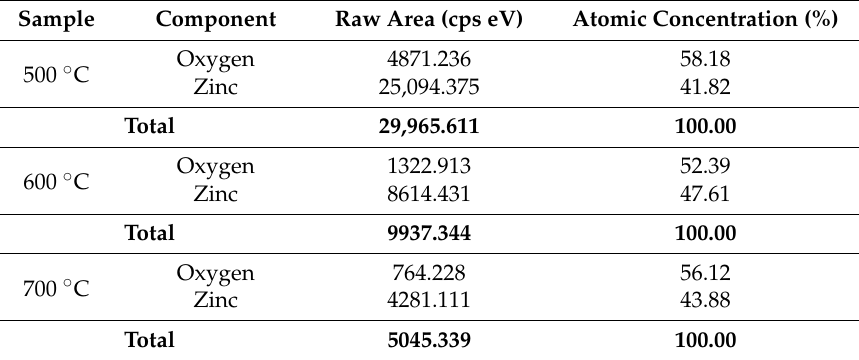
Table 1. Relative atomic concentration for components in oxygen to